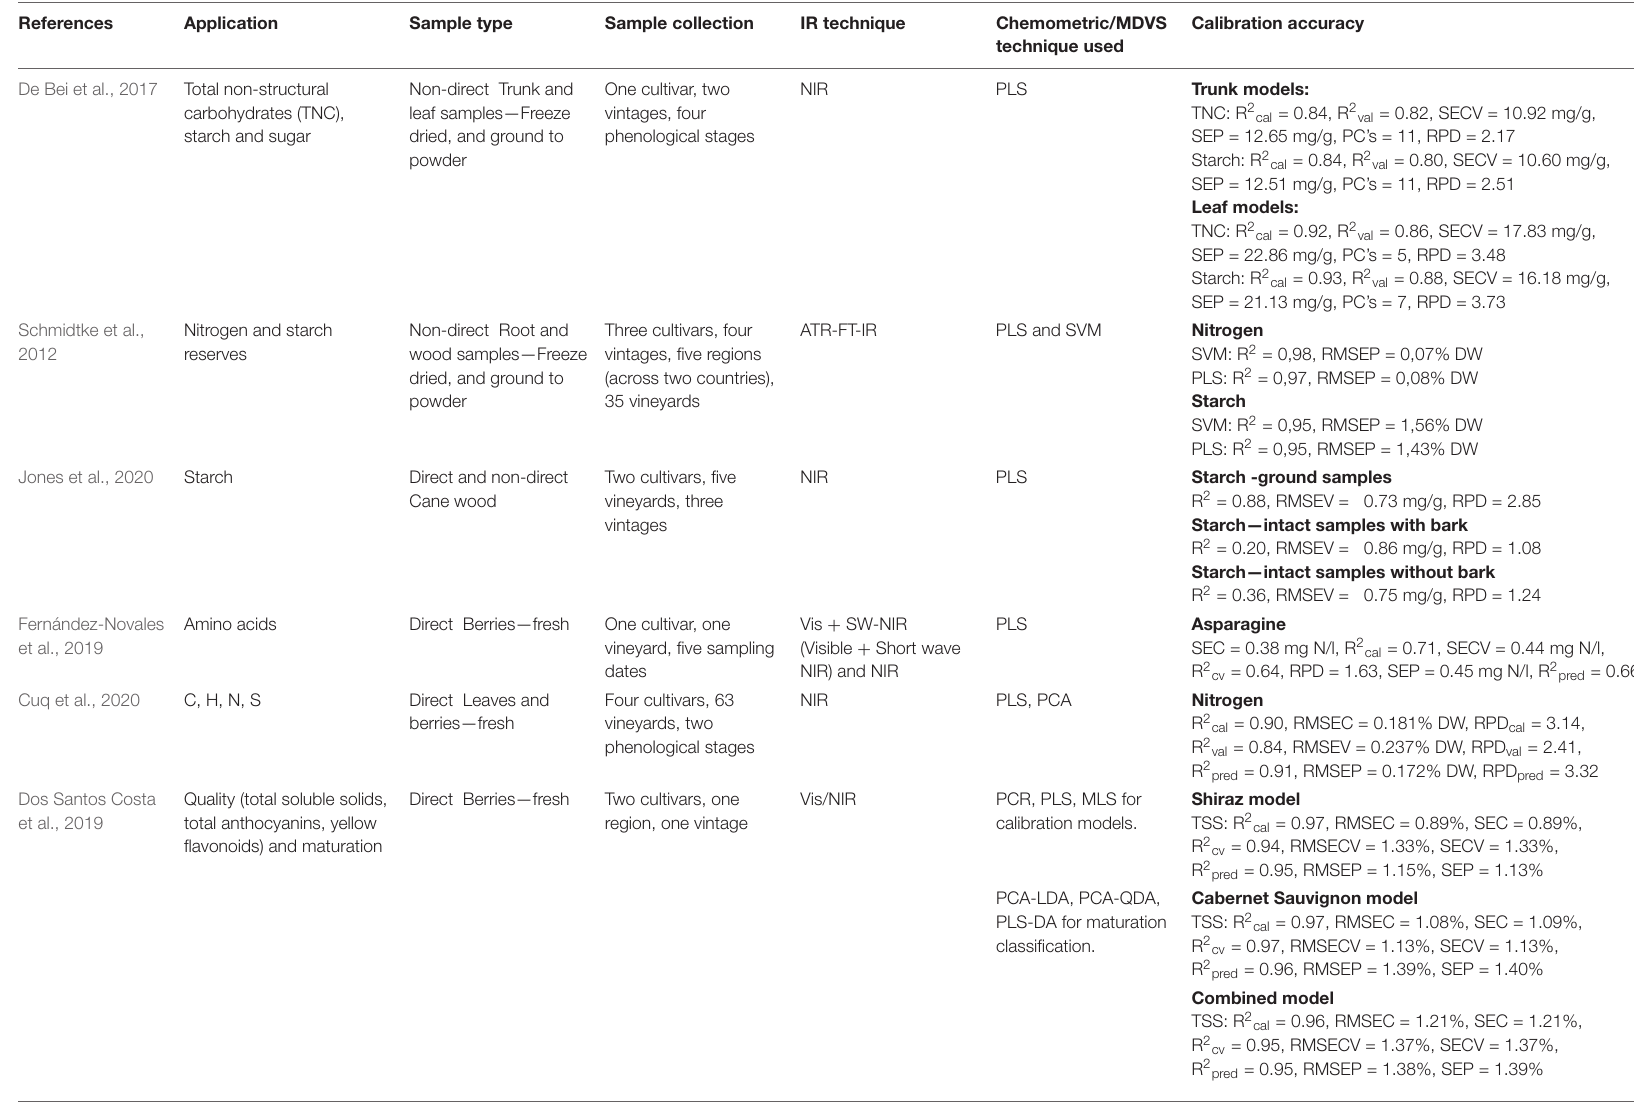
TABLE 2 | Direct and non-direct applications of infrared spectroscopy for quantification tasks in